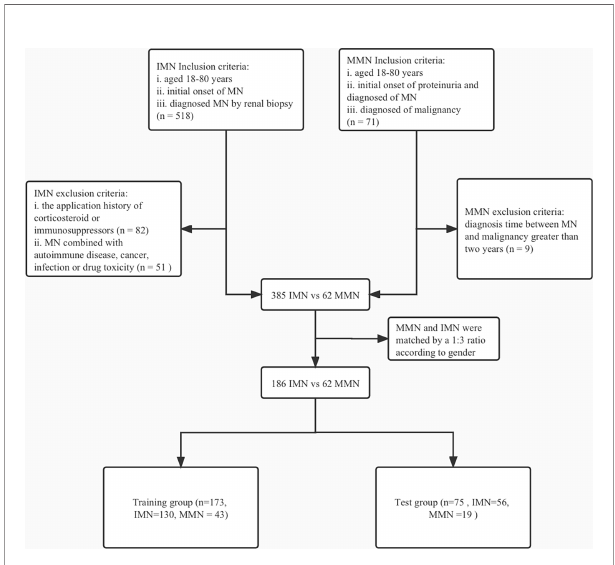
FIGURE 1 | Flowchart of enrollment and exclusion in training and test group. IMN, idiopathic membranous nephropathy; MN, membranous nephropathy; MMN, malignancy-associated membranous